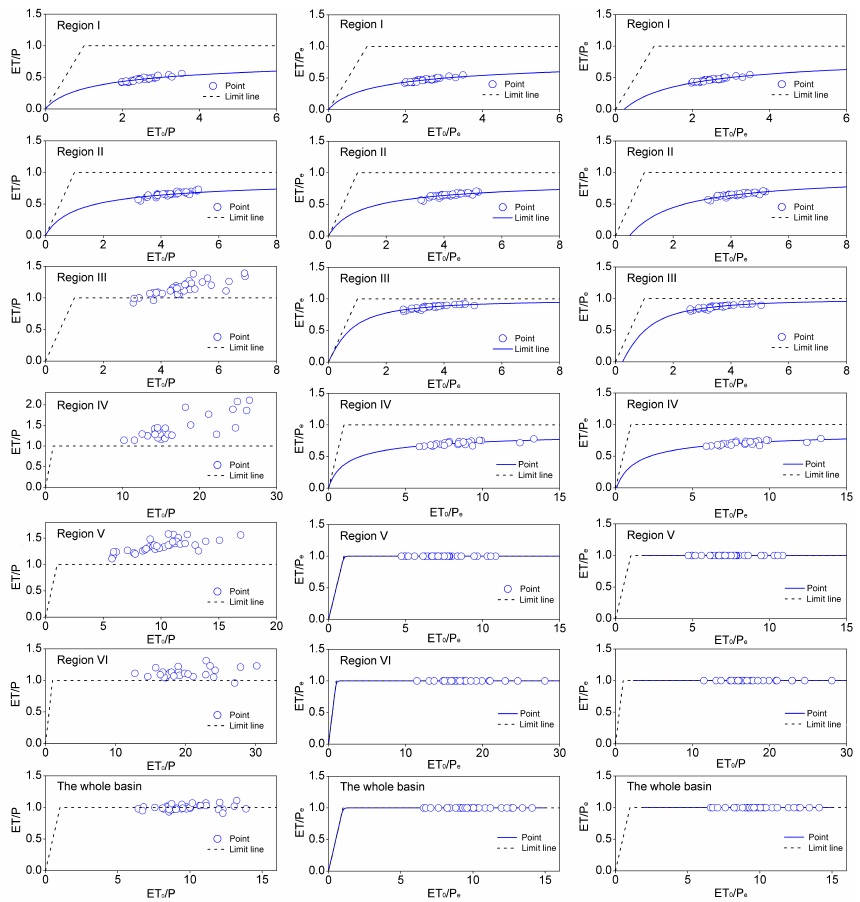
Figure 8. Comparison of the original Budyko curves (left panel) and the new Fu-type Budyko curves (middle panel, with λ = 0) and the new Fu-type Budyko curves (right panel, with λ >0) for regions I–VI and the whole basin at the annual